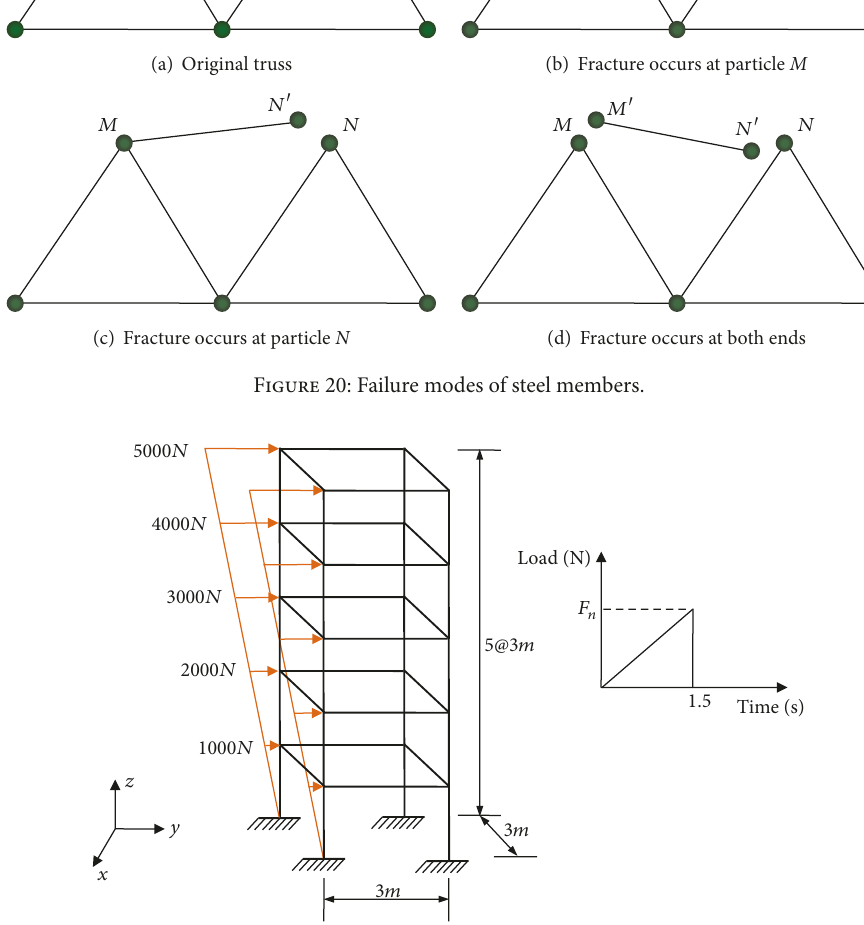
Figure 21: Five-story space steel